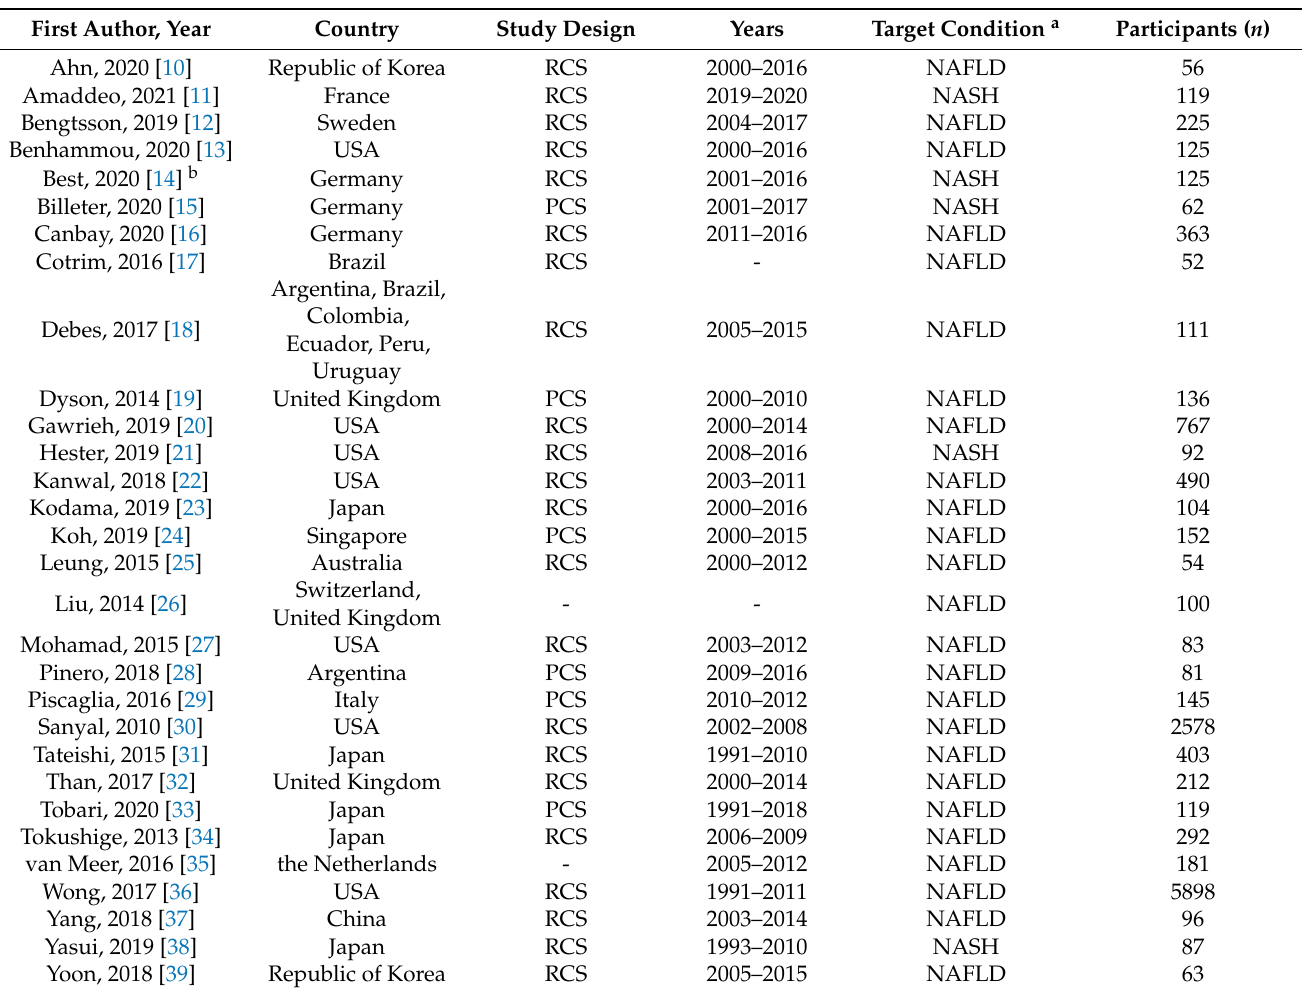
Table 1. Characteristics of included